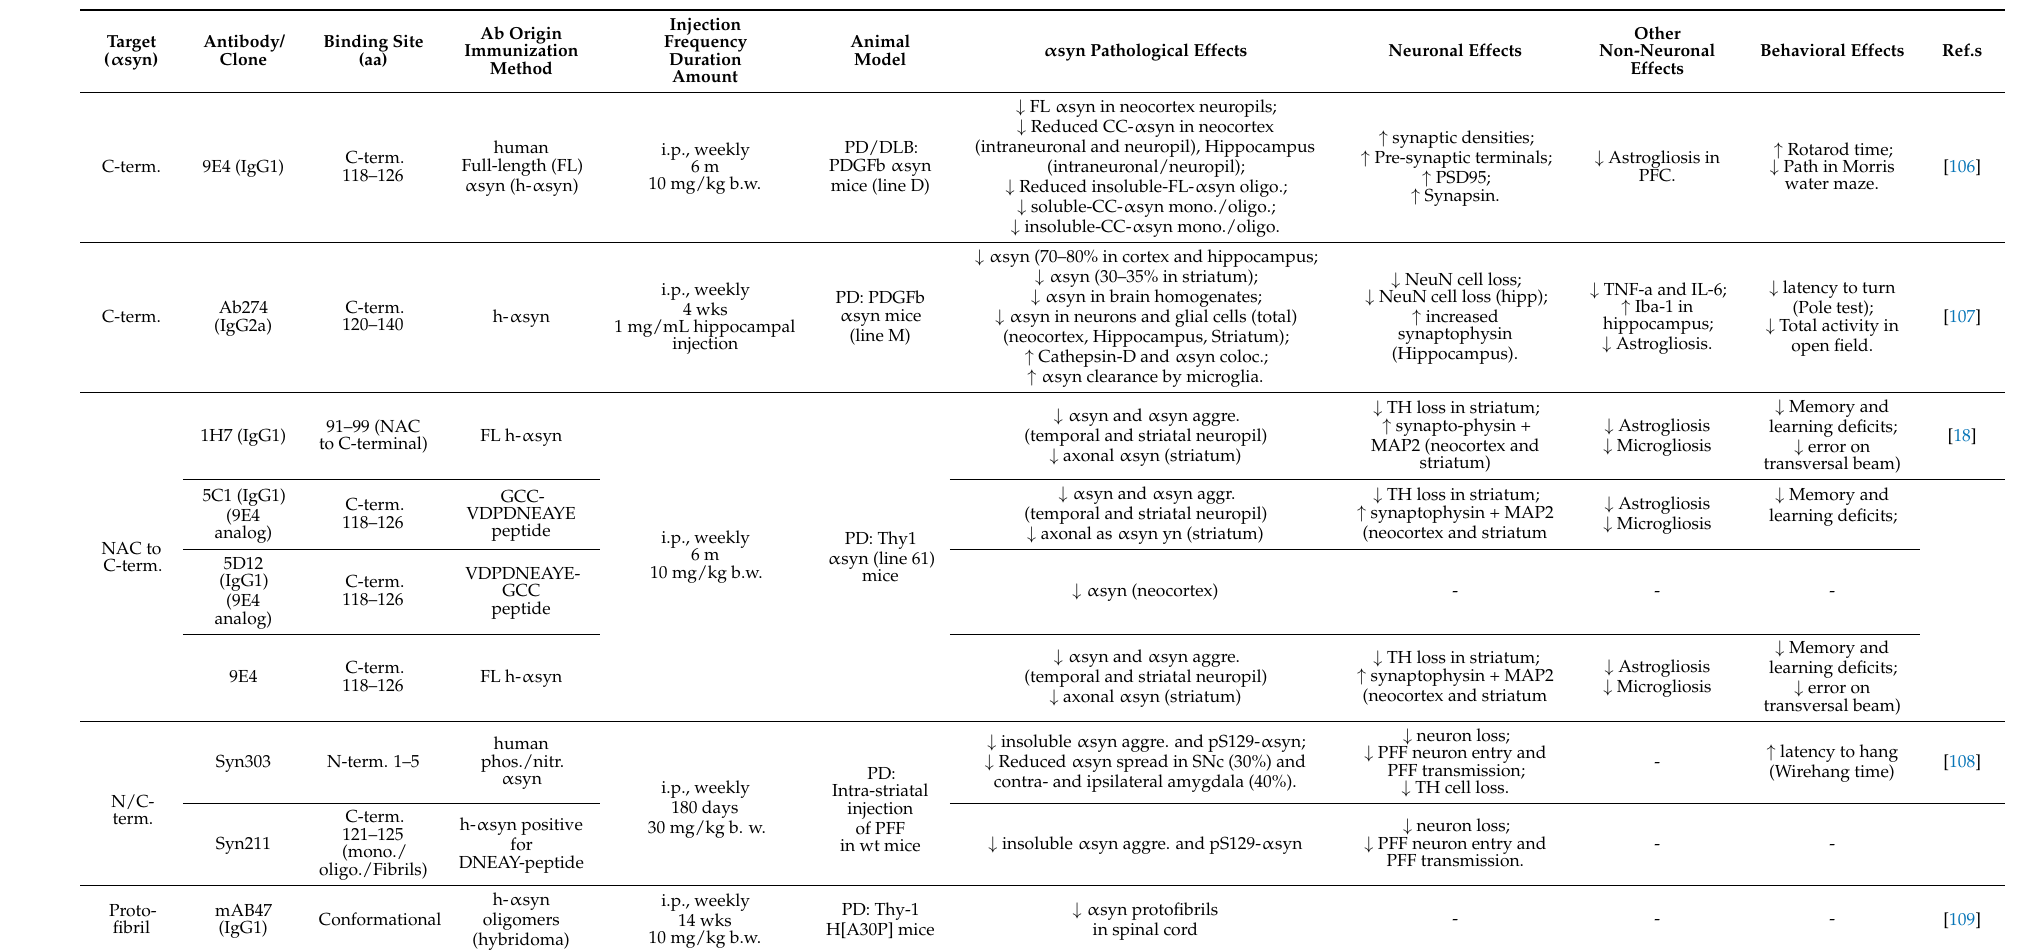
Table 1. Passive immunization studies in Parkinsonian animal